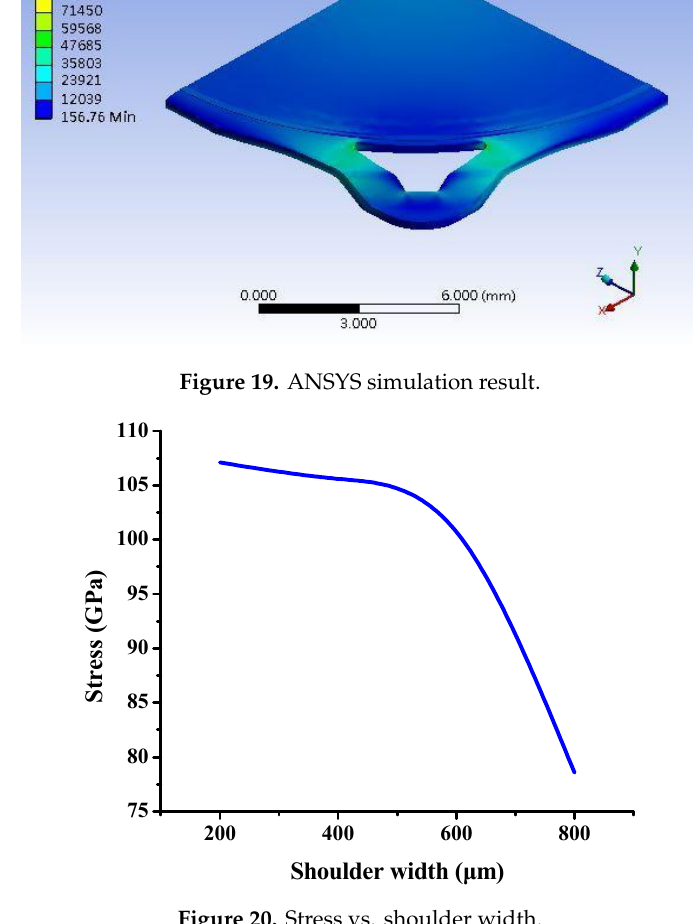
Figure 20. Stress vs. shoulder width.